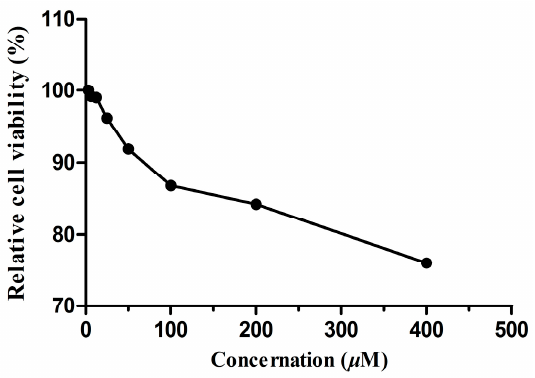
Figure 8. The toxicity of dryocrassin ABBA on MDCK cells. Culture medium in 96-well plates were removed and cells were washed with PBS. Then, 100 μ L dryocrassin ABBA solution at different concentrations were added. After incubation at 37 °C in 5% CO 2 for 72 h, the relative cell viability was investigated by CCK8 assay.